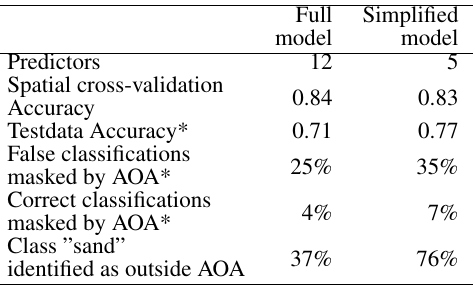
Table 2. Effects of the spatial variable selection on the classification accuracy and AOA. (*) The class ”sand”